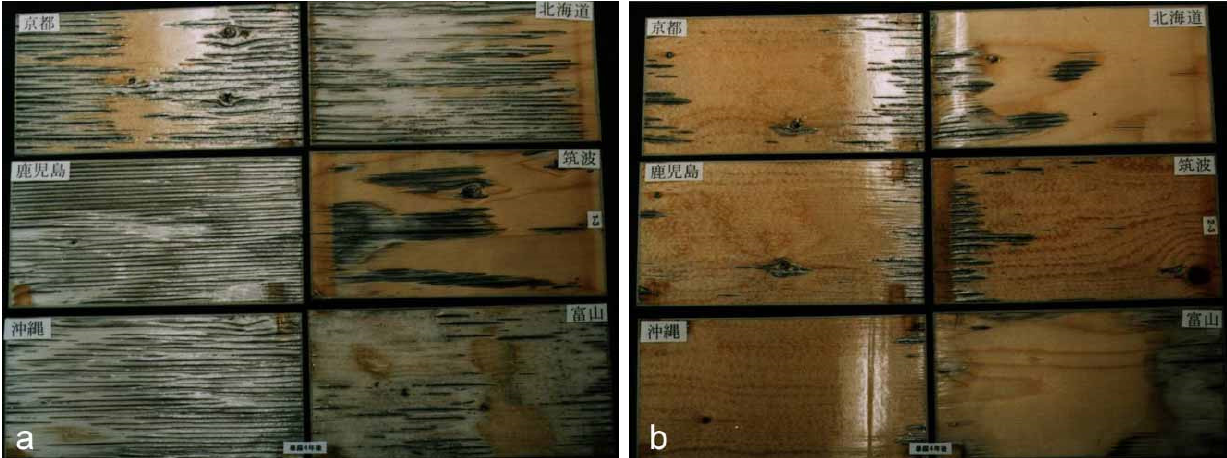
Figure 8. Effect of a polyethylene glycol (PEG) pre-treatment on the performance of a clear coating on Douglas fir plywood panels exposed outdoors for two years at six different sites in Japan: ( a ) Untreated clear-coated panels; ( b ) Clear-coated panels pre-treated with 10%